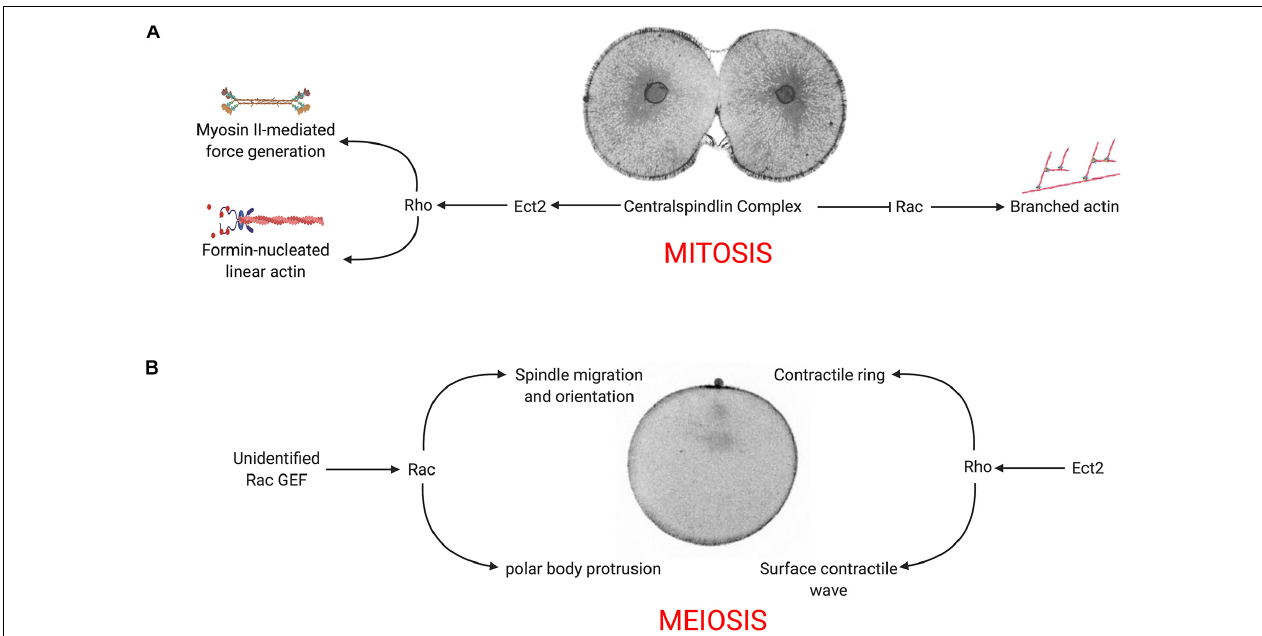
FIGURE 6 | Model for Rac-Arp2/3 signaling during mitotic and meiotic divisions. (A) In the presence of WT Rac, the centralspindlin complex recruits Ect2 to promote equatorial Rho activity, which in turn stimulates formin-nucleated actin, myosin II activation and contractile ring assembly. Simultaneously, centralspindlin blocks Rac and Arp2/3 activity, downregulating branched actin networks at the cell equator. (B) During meiosis, Rho is activated at the vegetal pole, inducing a surface contractile wave that converges on the animal pole where the centralspindlin complex organizes the ring that completes cytokinesis and polar body extrusion. Rac (activated by an unidentified exchange factor) promotes Arp2/3-mediated branched actin that is required for proper positioning of the spindle and polar body protrusion.